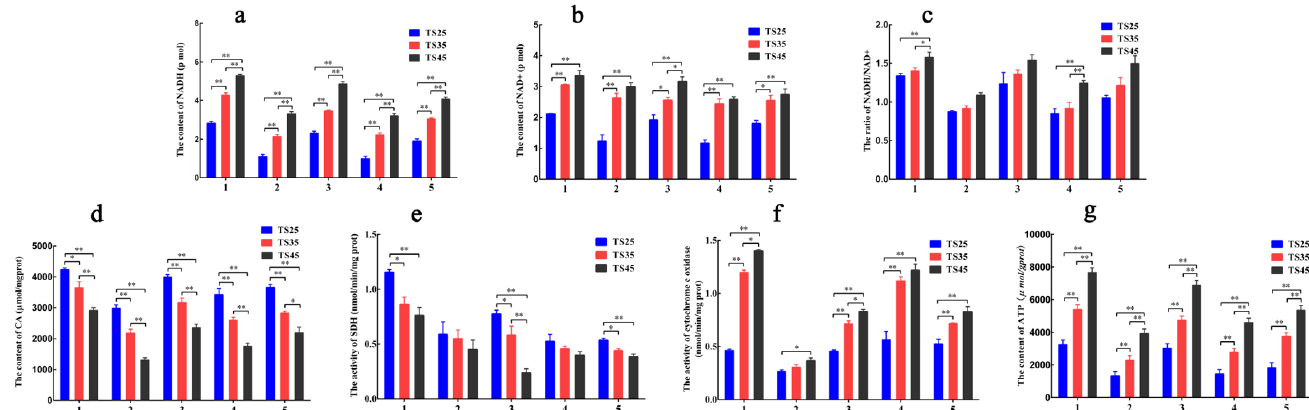
Figure 10. Analysis of mitochondria function-related indexes in five tissues of Tibetan sheep. ( a ) Nicotinamide adenine dinucleotide (NADH (reduced state)). ( b ) Nicotinamide adenine dinucleotide (NAD+ (oxidation state)). ( c ) The ratio of NADH/NAD+. ( d ) Citric acid (CA). ( e ) Succinate dehydrogenase (SDH). ( f ) Cytochrome c oxidase (CO). ( g ) Adenosine triphosphate (ATP). ( 1 – 5 ) Heart, liver, lung, brain, quadriceps femoris. ( TS25 ) 2500 m altitude Tibetan sheep. ( TS35 ) 3500 m altitude Tibetan sheep. ( TS45 ) 4500 m altitude Tibetan sheep. Date shown on graph are means ± SEM. * p < 0.05, ** p < 0.01.